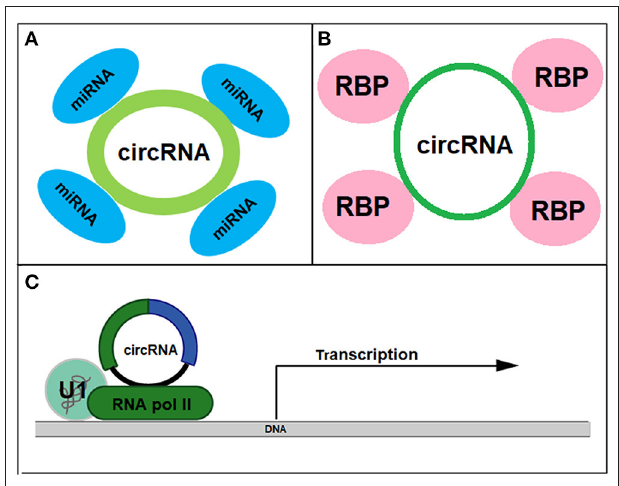
( Table 1 ) and they function as miRNA and protein sponges or transcriptional regulators to exert biological functions ( Figure 3